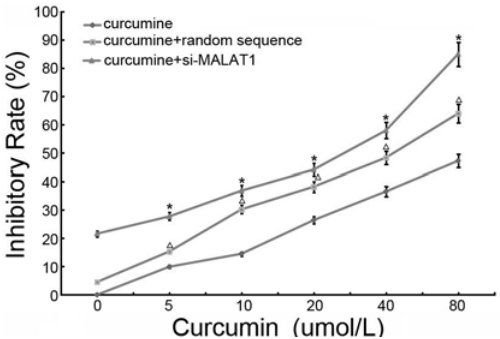
FIGURE 2 - Cell inhibition rates in the curcumin group, the curcumin and random sequence group, and the curcumin and si-MALAT1 group * P <0.05, P > 0.05, △